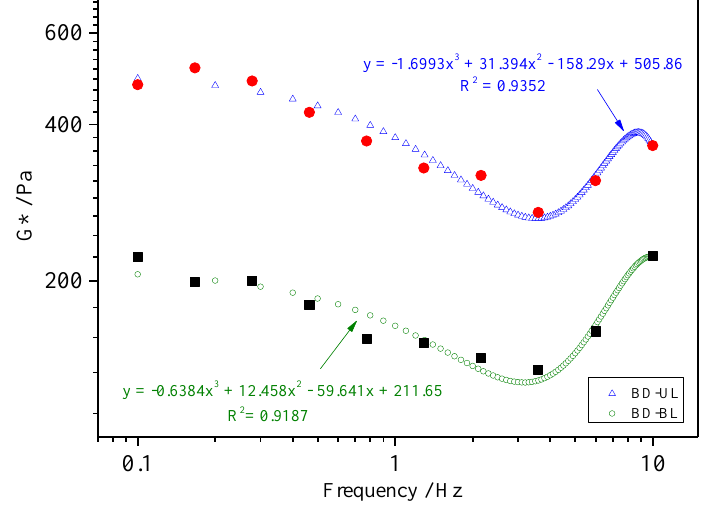
Figure 9. Complex shear modulus of bitumen from BD-UL and BD-BL. 229